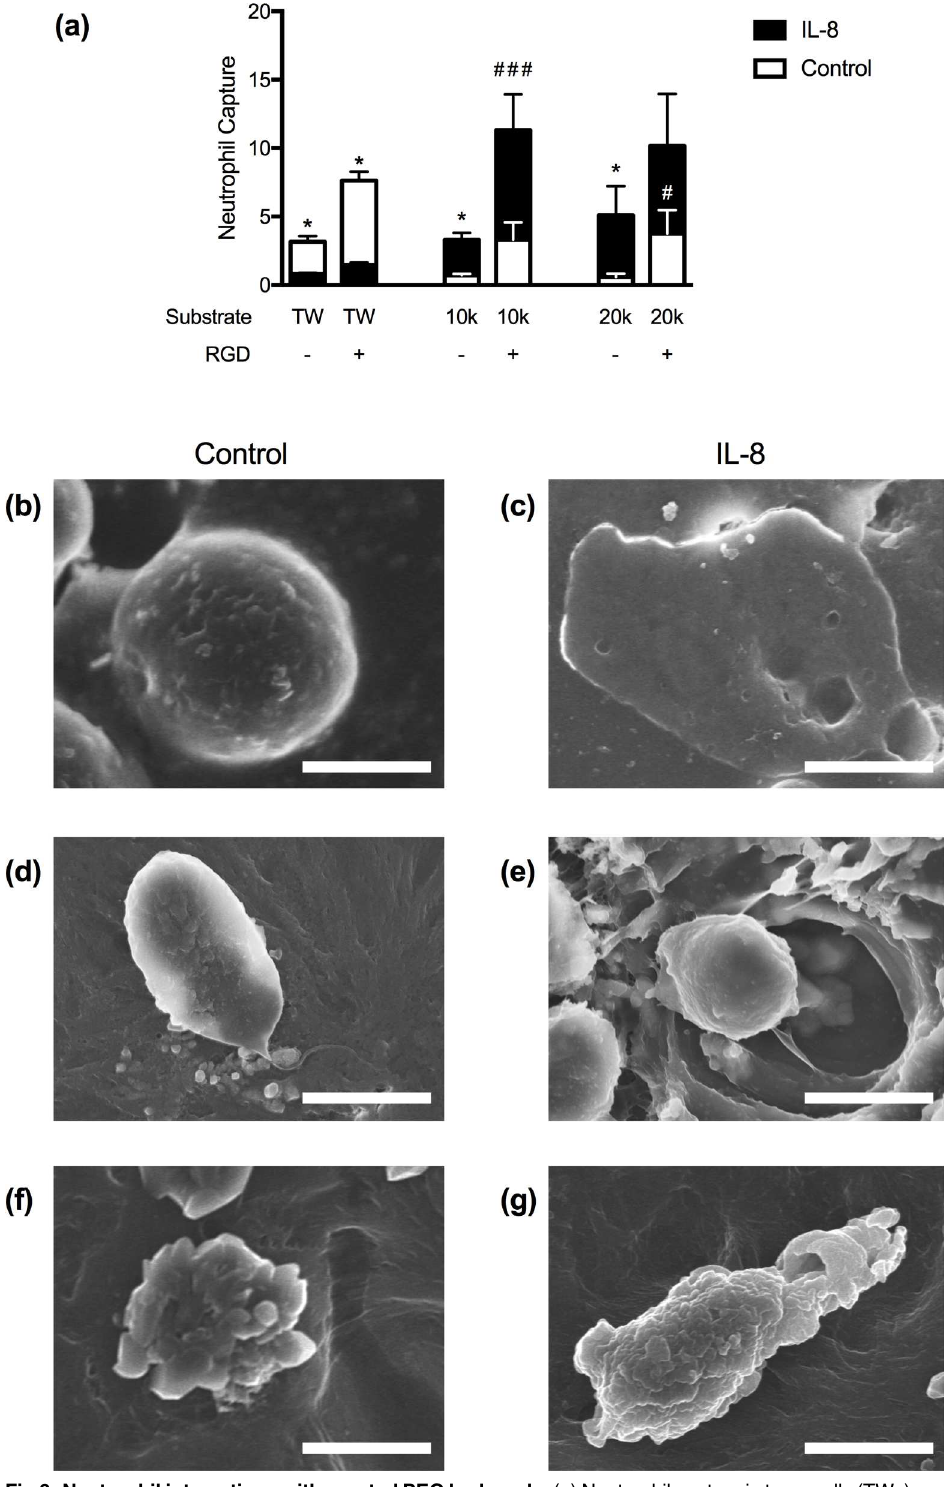
Fig 6. Neutrophil interactions with porated PEG hydrogels. (a) Neutrophil capture in transwells(TWs) and hydrogels without or with RGD. * p < 0.05for control v. IL-8 on the same scaffold, #p < 0.05,###p < 0.001for comparisons betweenthe same conditionon scaffolds +/- RGD. All statistical differencesdeterminedby a two-way ANOVA. Changesare not significantunless otherwisedenoted.(b-g) SEM micrographs of